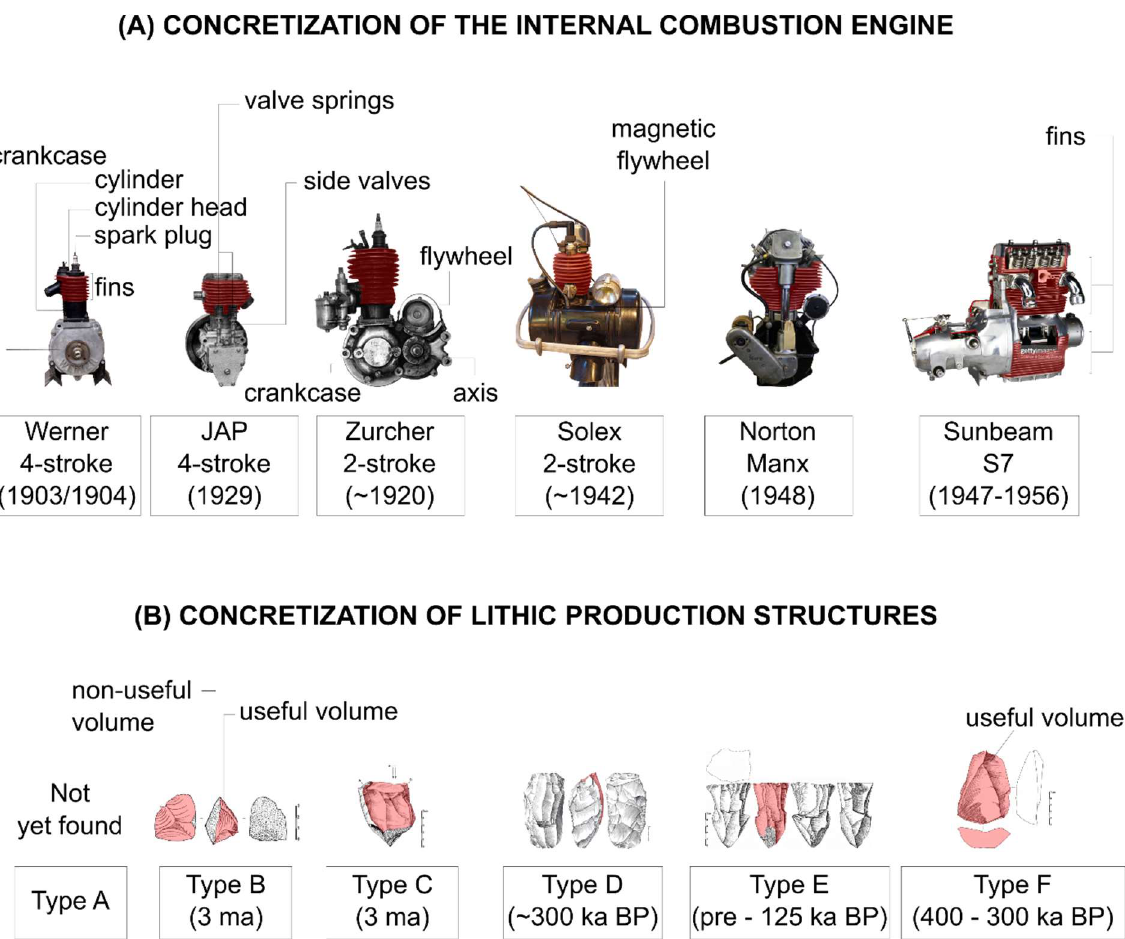
Figure 7. Example of concretisation of technical objects. (A) Concretisation of the internal combustion engine (elaborated from Simondon 2012: 20-26). The area coloured red in each engine corresponds to the fins which, over time, begin to gain more space in the engine structure. In other words, the fins begin to integrate more effectively with the other elements. (B) Concretisation of lithic production structures (elaborated from Boëda 2013: 60-72), using archaeological cores from different archaeological sites. The area coloured red in each core corresponds to the useful volumes ( sensu Boëda 2013: 89) which, over time, also start to gain more space in the core